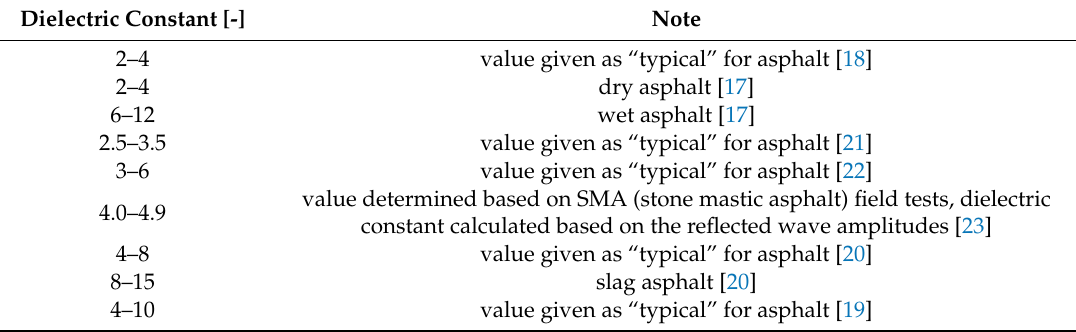
Table 1. Dielectric constants of asphalt mixtures published in the